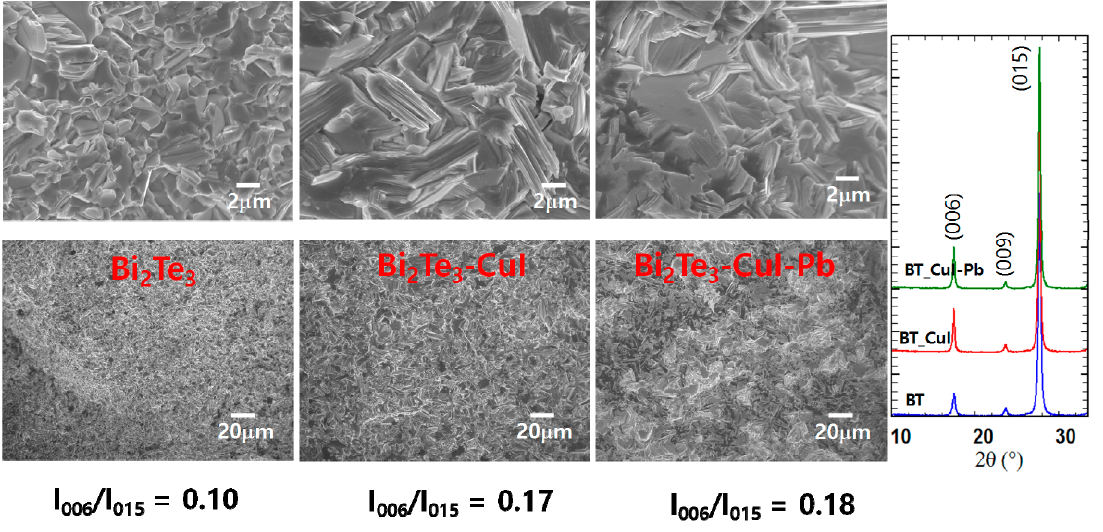
Figure 2. SEM images, and XRD patterns of undoped Bi 2 Te 3 , 1% CuI-doped Bi 2 Te 3 , and 1% CuI-Pb co-doped Bi 2 Te 3 .